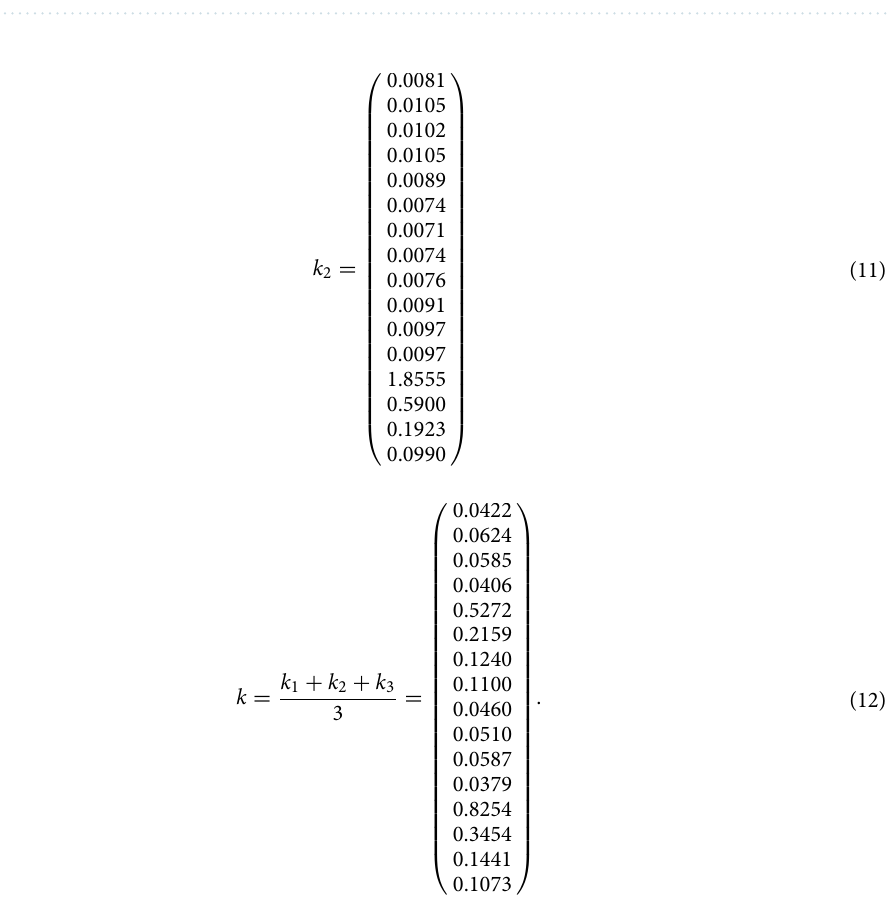
Table 4. Analysis of variance of orthogonal